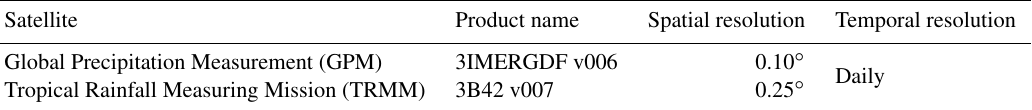
Table B4. Precipitation